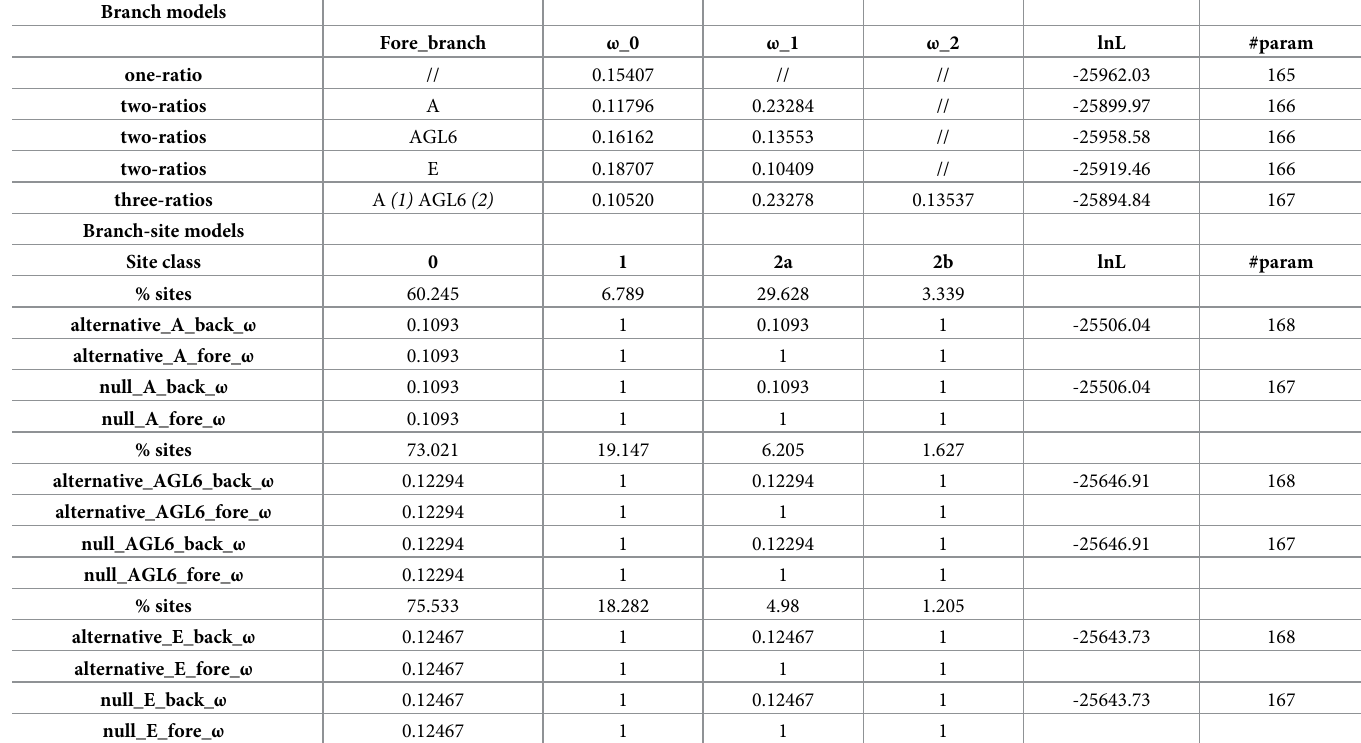
Table 1. Models used and parameters estimated under different conditions for the evolutionary analysis of the orchid class A, AGL6 and class E MADS-box genes. The parameter estimates of the branch and branch-site models were obtained from the CODEML analysis. Fore, foreground branch; back, background branch; param, parameters. The results of the LRT are reported in S3